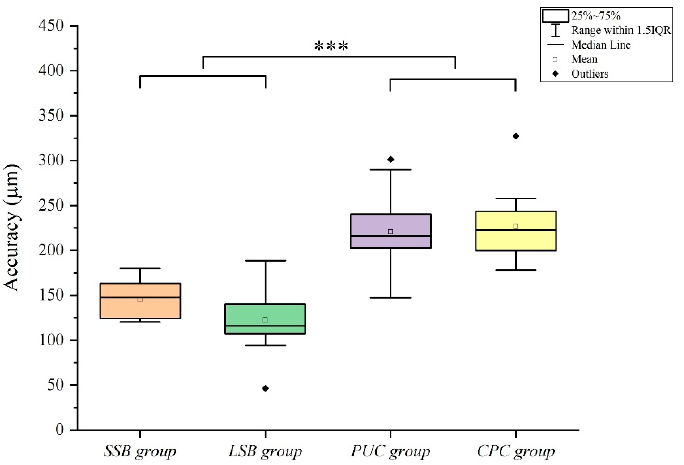
Figure 7. Comparison of accuracy of occlusal contact among four groups. SSB, short scan body;